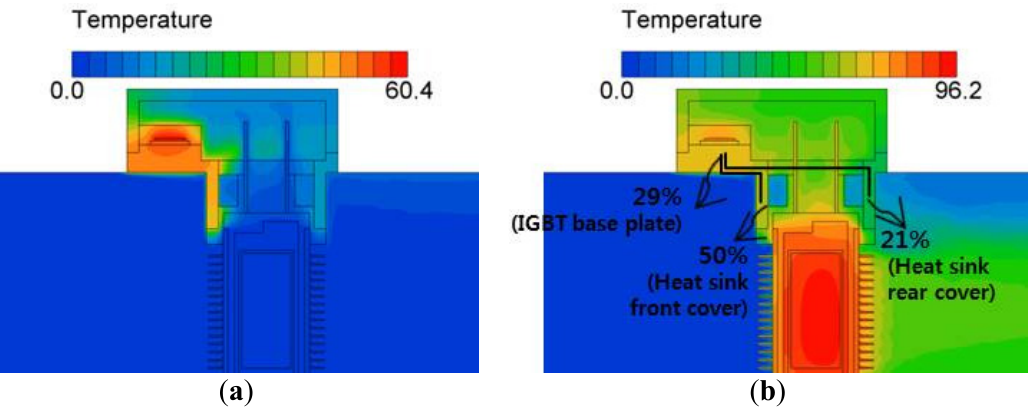
Figure 7. Comparison of the temperature distributions in the PTC heater under the basic condition with and without operation of the heater ( ˝ C). ( a ) Without operation of the heater; ( b ) With operation of the heater.